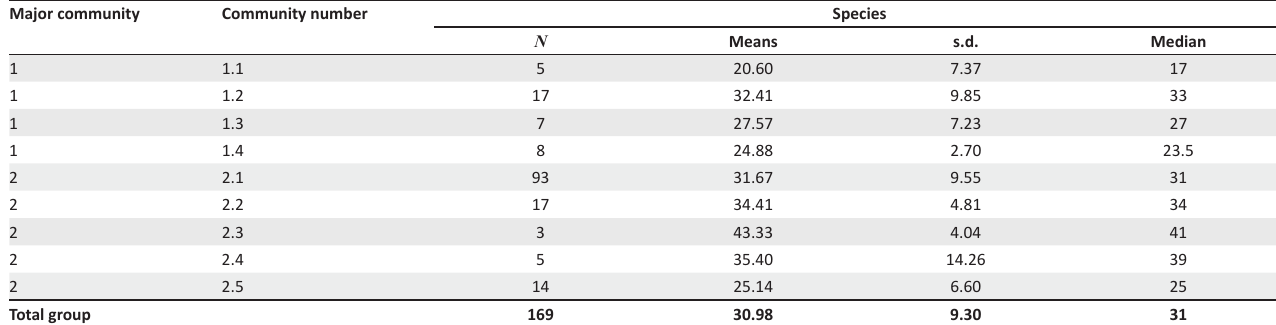
TABLE 2: Species abundance for the different communities within each of the major